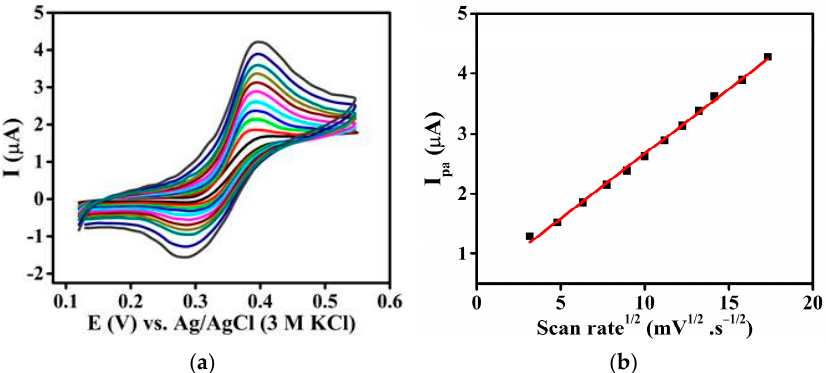
Figure 5. ( a ) CVs of Sp-At/MWCNTs/CPE in 0.1 M phosphate buffer (pH 4) containing 30 µ M GA at different scan rates (20–300 mV · s − 1 ). ( b ) The plot of the relationship between I pa and the square root of the scan rate.